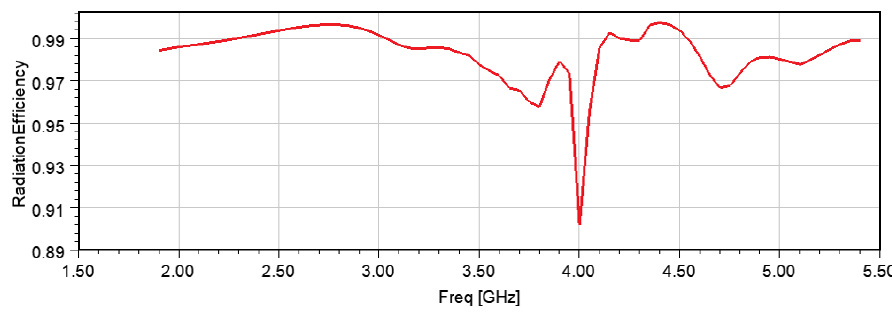
Figure 15. Radiation efficiency of the proposed antenna 2.